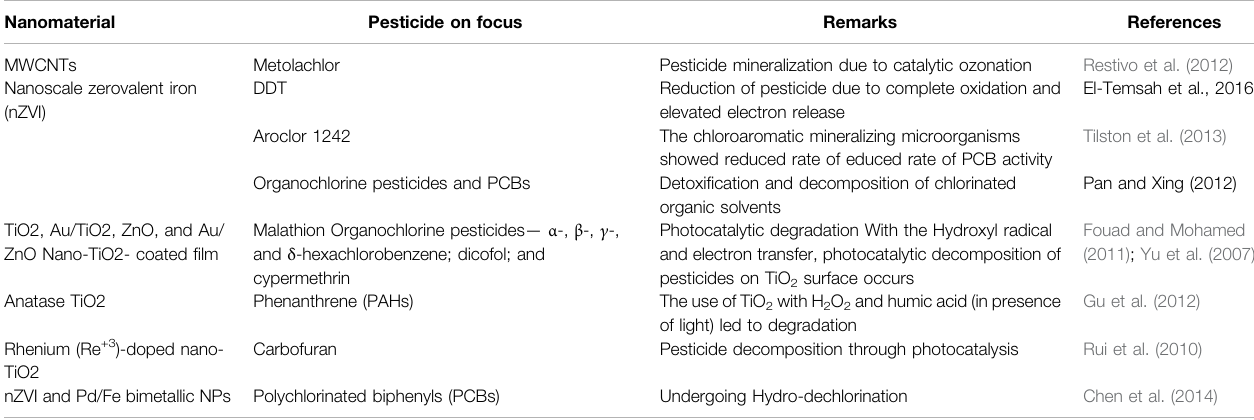
TABLE 3 | The use of Nanotechnology for pesticides and POP